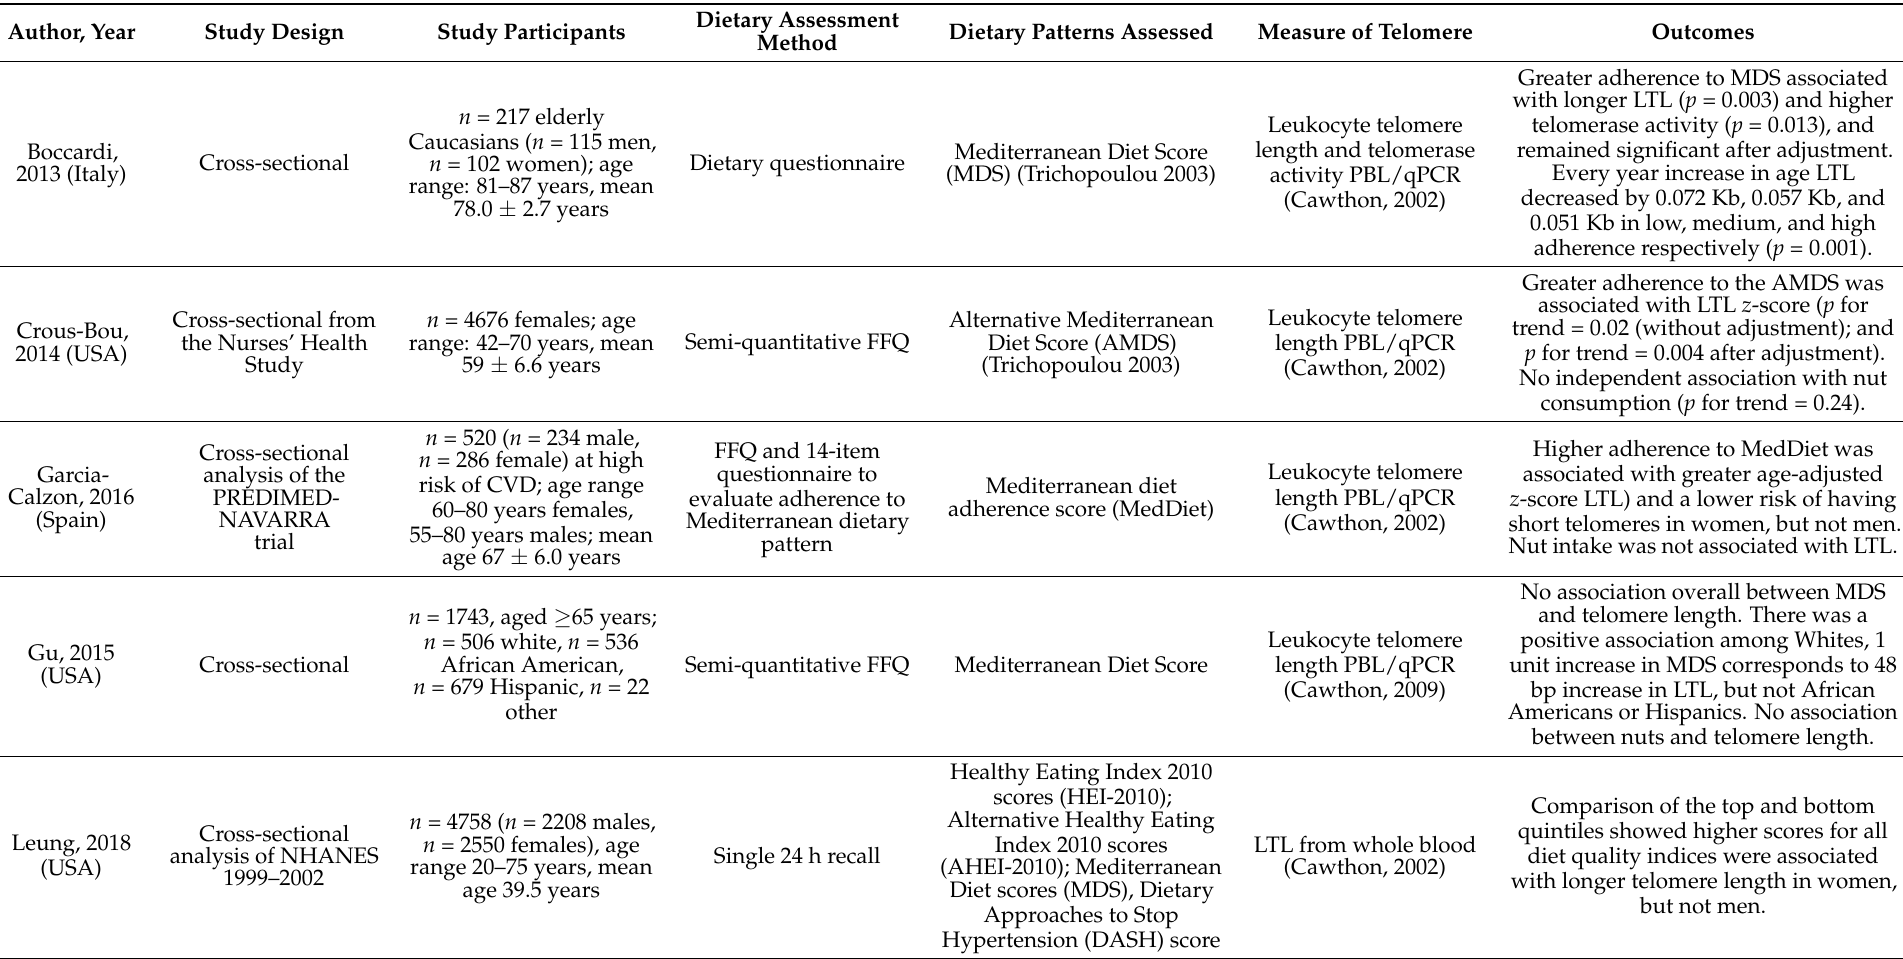
Table 1. Nut consumption and